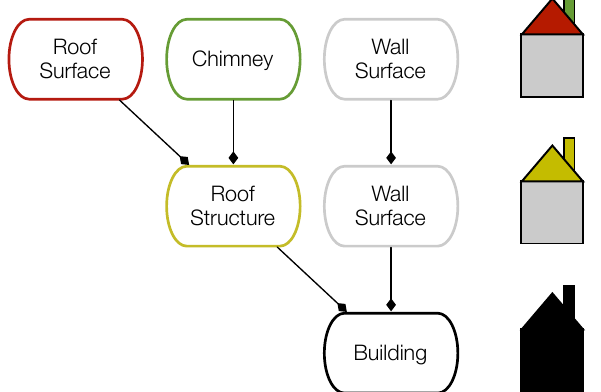
Figure 10: Three datasets in same geometric level of detail with different semantic detail and granularity. Since the semantics are different, we consider these as three different levels of